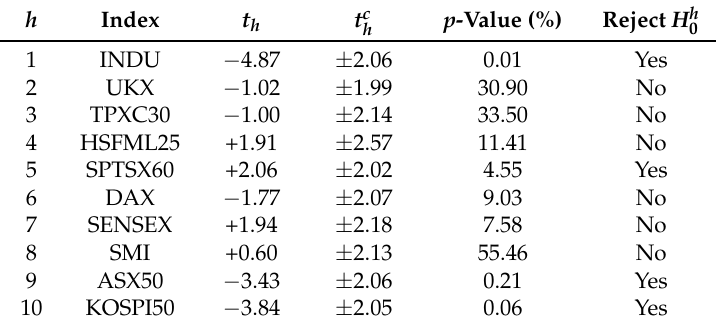
Table 7. Geographical stability test (95%) for γ ◦ : 2005–2014.